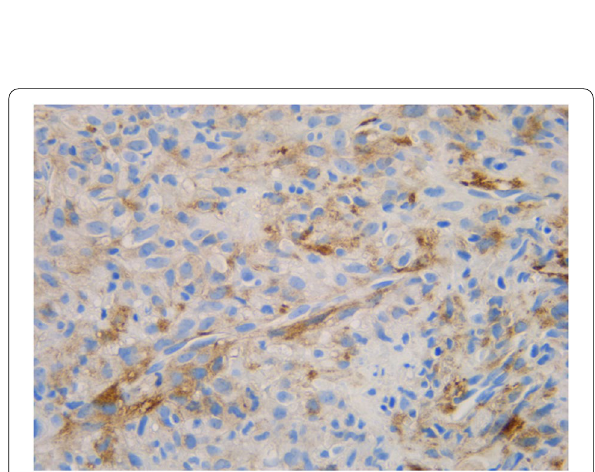
Fig. 5 Presence of focal expression of H-caldesmon